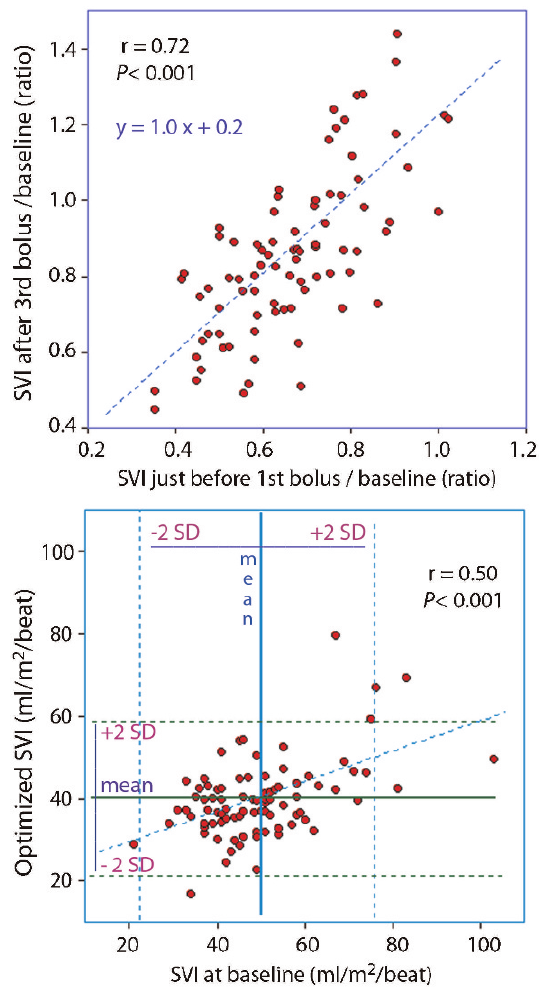
Figure 3 - The relative change in stroke volume index (SVI) during fluid volume optimization with starch, which increased SVI by approximately 20% (top). The optimized SVI had a smaller variability than did SVI at baseline, i.e., before the induction of anesthesia